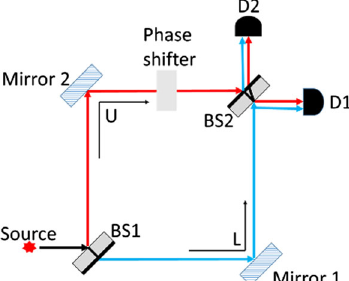
FIG. 4. Mach-Zehnder interferometer with beam splitter 2